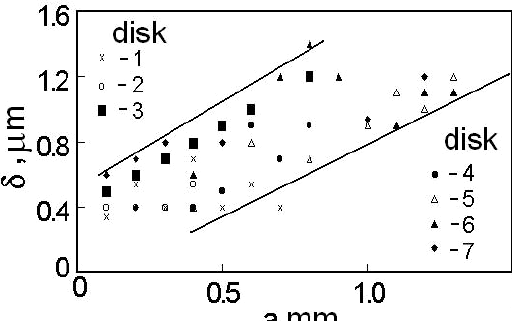
Figure 7: The changing trend of the value  of fatigue-striation spacing along the crack-growth direction (minor axis a of the crack front shape) for the group of examined disks (disk data are given in Tab. 1).